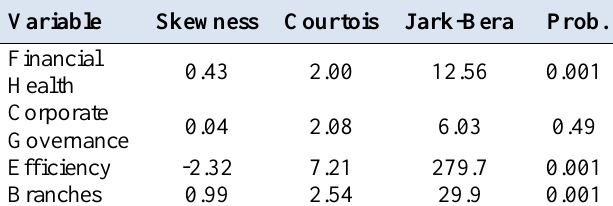
Table 2-2 . Results from descriptive statistics of